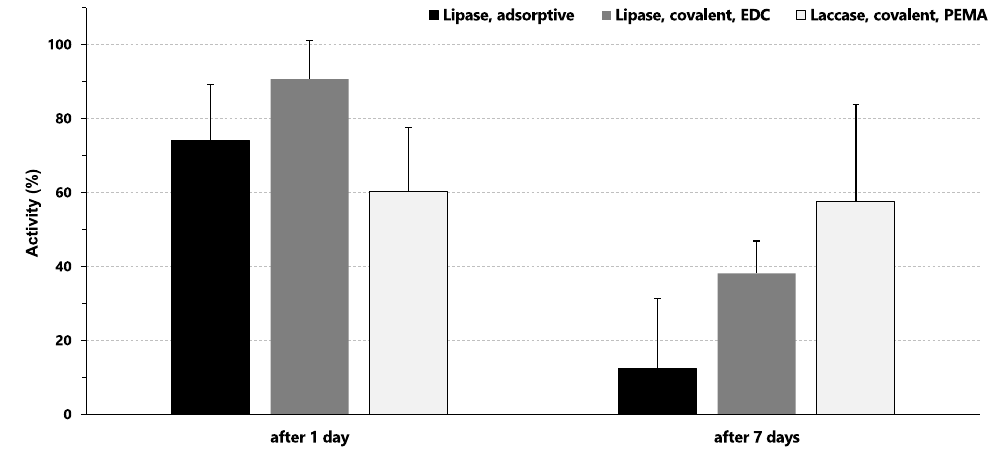
Figure 3. Remaining relative activity of lipase and laccase on BT after storage for one or seven days, respectively. Lipase-loaded BT was stored at − 18 ◦ C and laccase-loaded PEMA-BT at 4 ◦